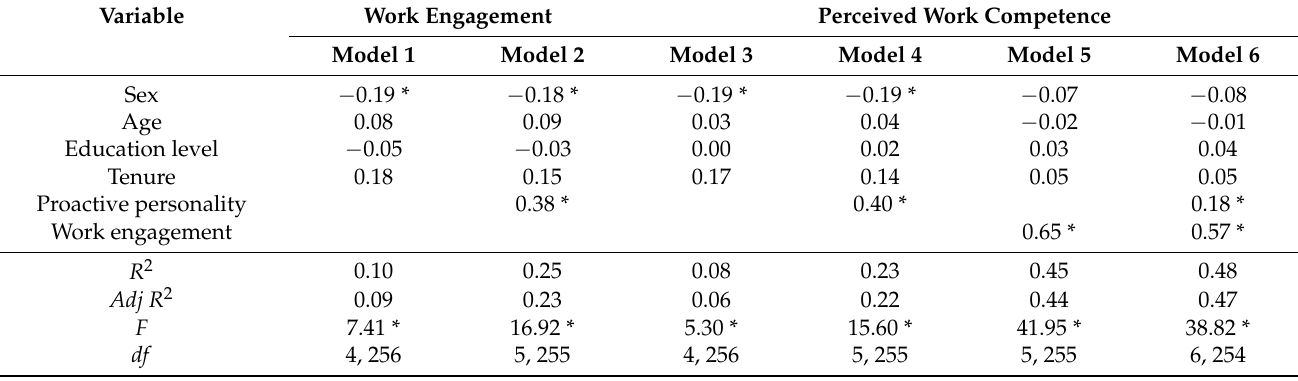
Table 2. Mediation analysis.